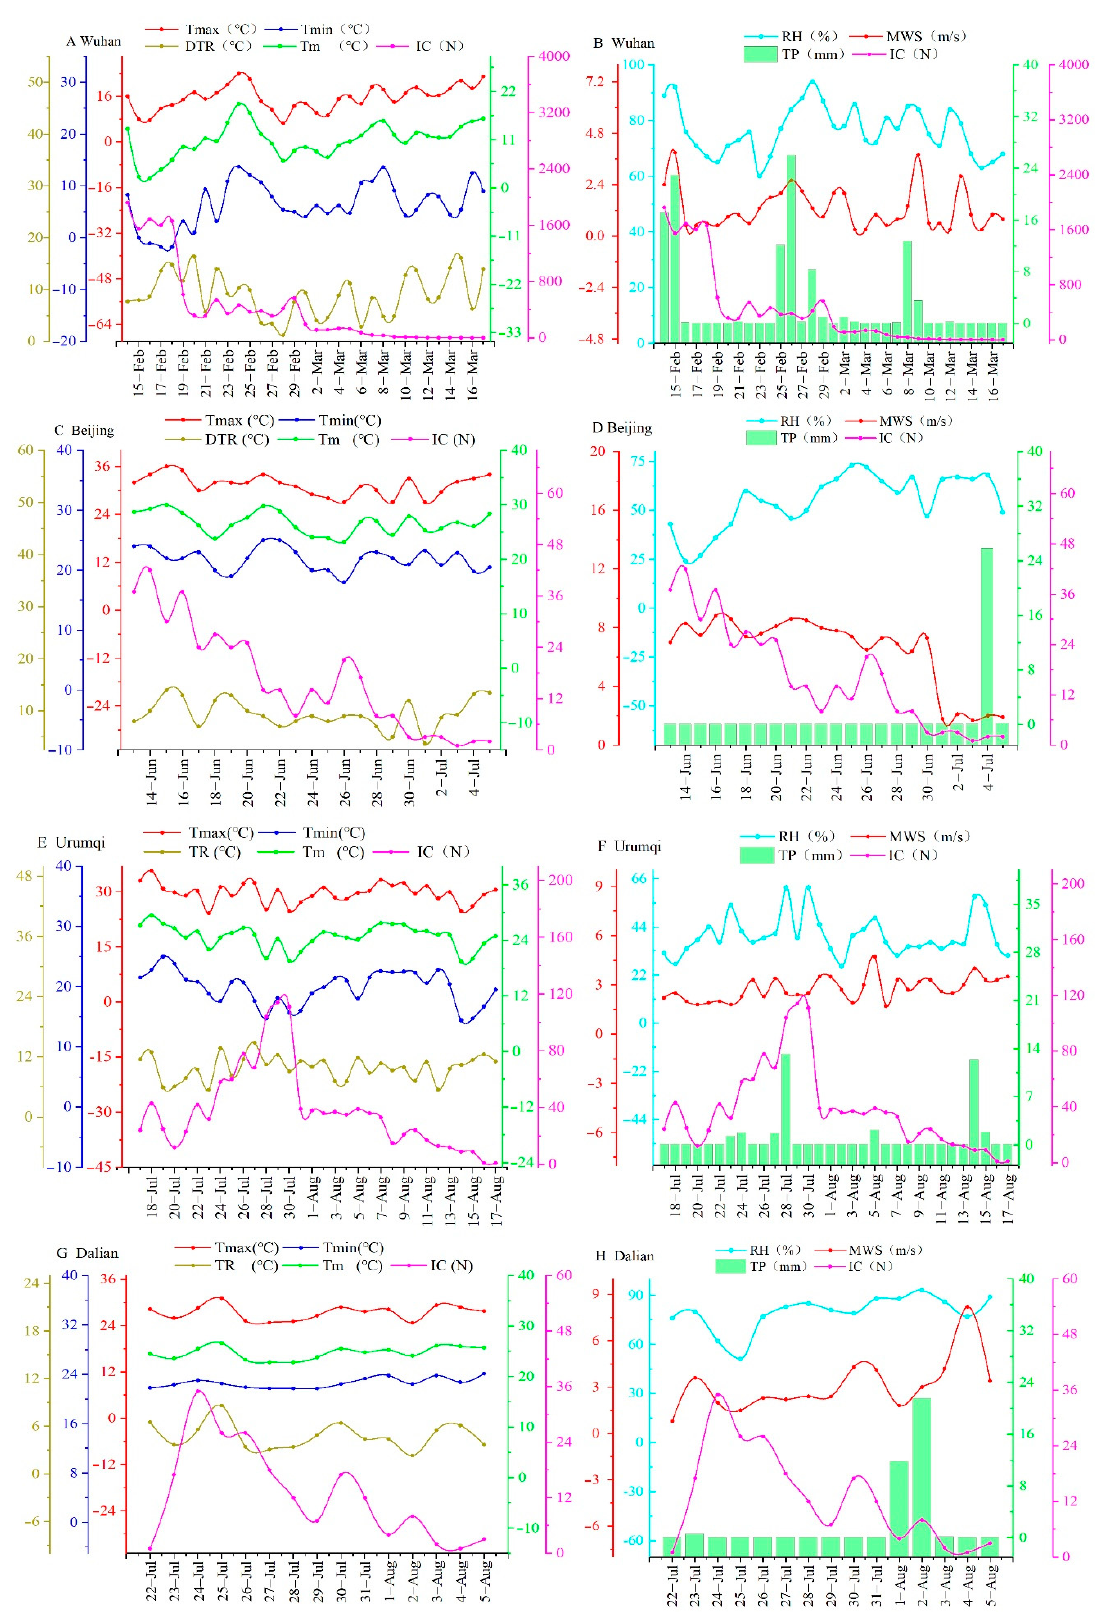
Figure 1. Changes in COVID-19 infected cases and meteorological factors during the period of community-based epidemic prevention and control in four cities. T max , T min , DTR, T m , RH, MWS and TP represent daily maximum temperature, minimum temperature, temperature range, average daily temperature, air relative humidity, average wind speed and precipitation, respectively. IC refers to COVID-19 infected